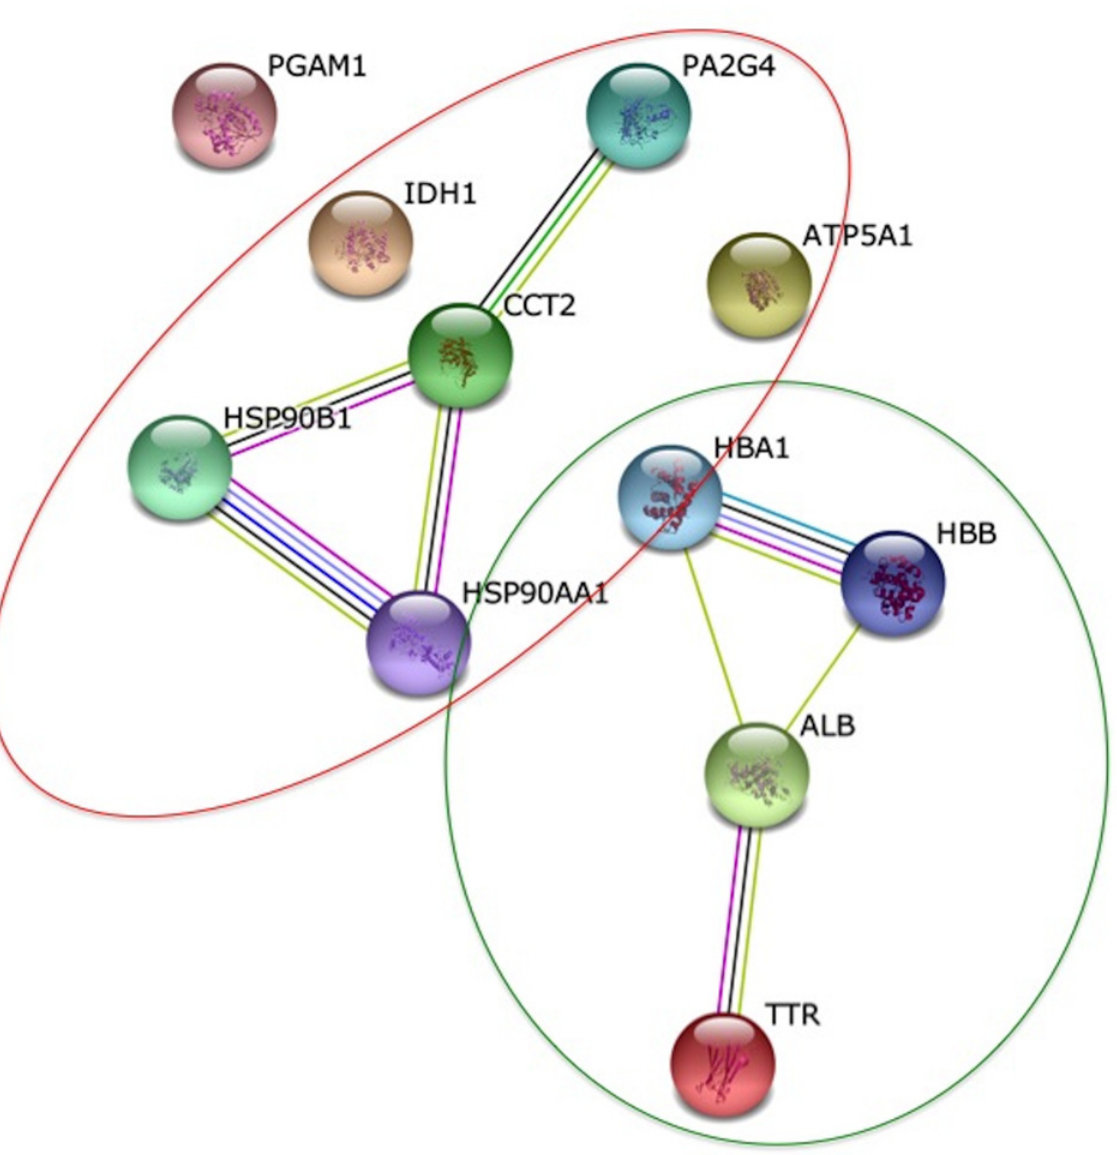
Fig 4. Protein interaction network of altered proteins at Day 14. In the network generated by STRING v.9.1, each node represents a protein and each edge represents an interaction, coloured by evidence type (see STRING website for colour legend). The original graphic output was modified including circles to group the proteins according to their regulation. A green line means upregulation and a red line downregulation.